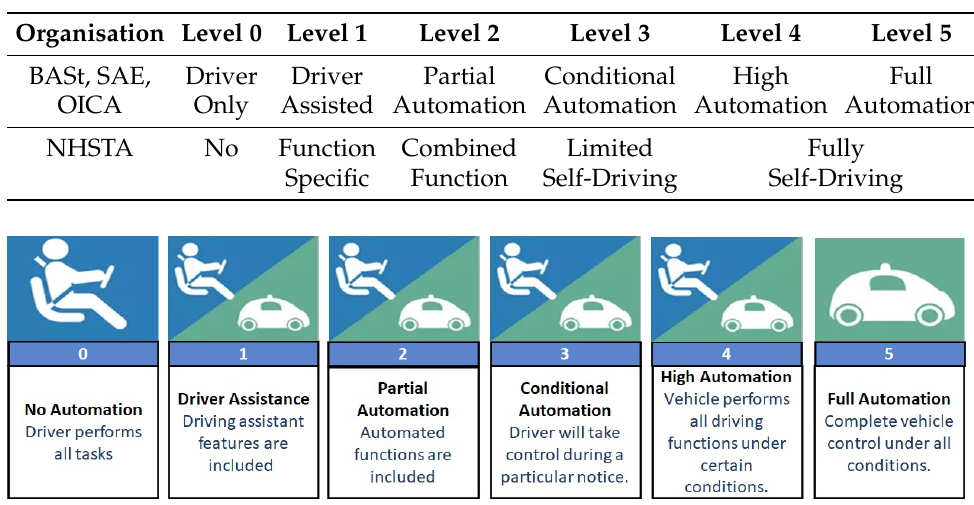
Table 1. Comparison between different automation levels.